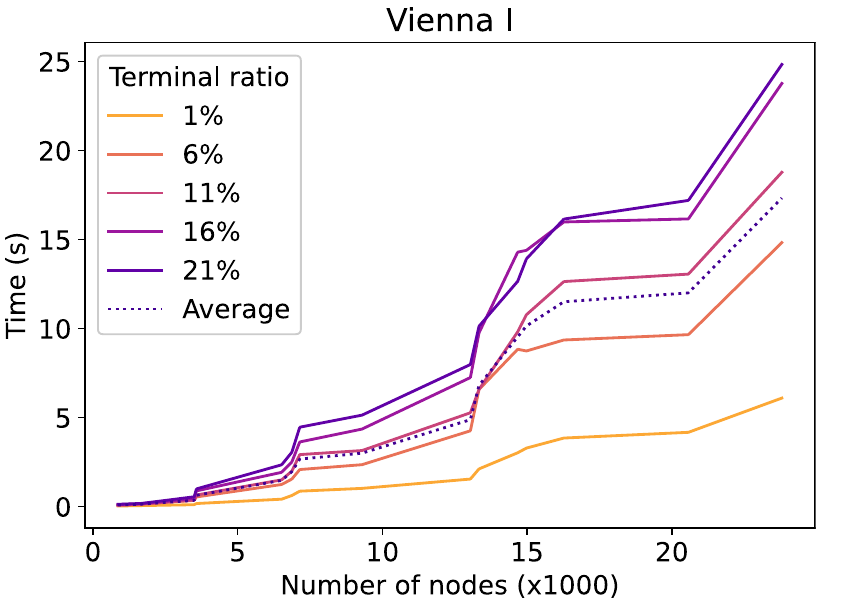
Fig 9. Vienna I CSPH time evolution by terminal ratio. The time in relation to the number of nodes. For each line, a different percentage of nodes is a terminal.